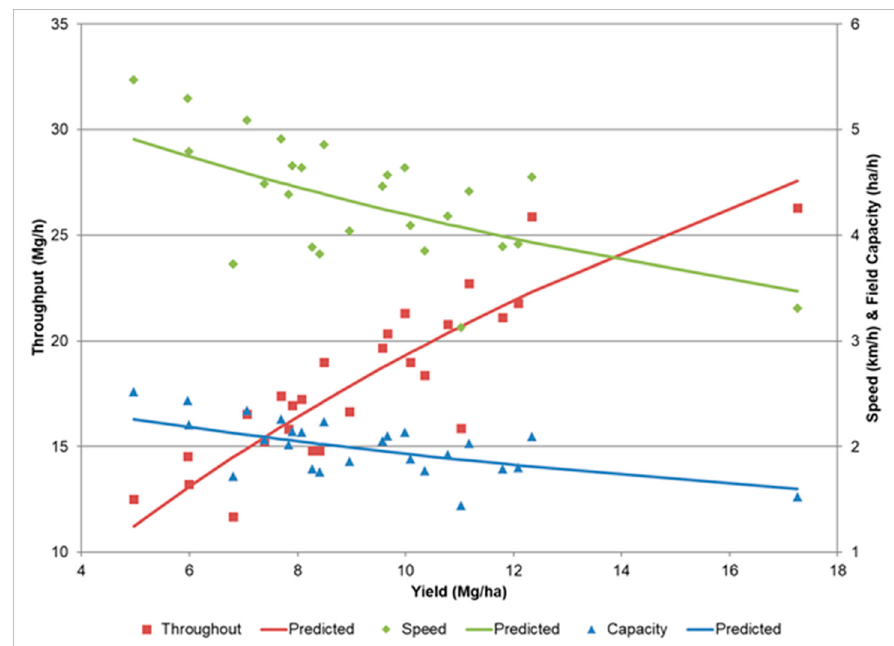
Figure 6. Effect of wrap-eject time on baler performance. This graph shows productivity, including time spent wrapping and ejecting the bale, for field 6. The individual points are observations from field data. The solid lines (green—effective speed, red—throughput, blue—achieved field capacity) are predicted [4] assuming v e = 8.0 km/h, E f = 0.74, W s = 4.6 m, t e = 23 s, and M b = 0.43 Mg.